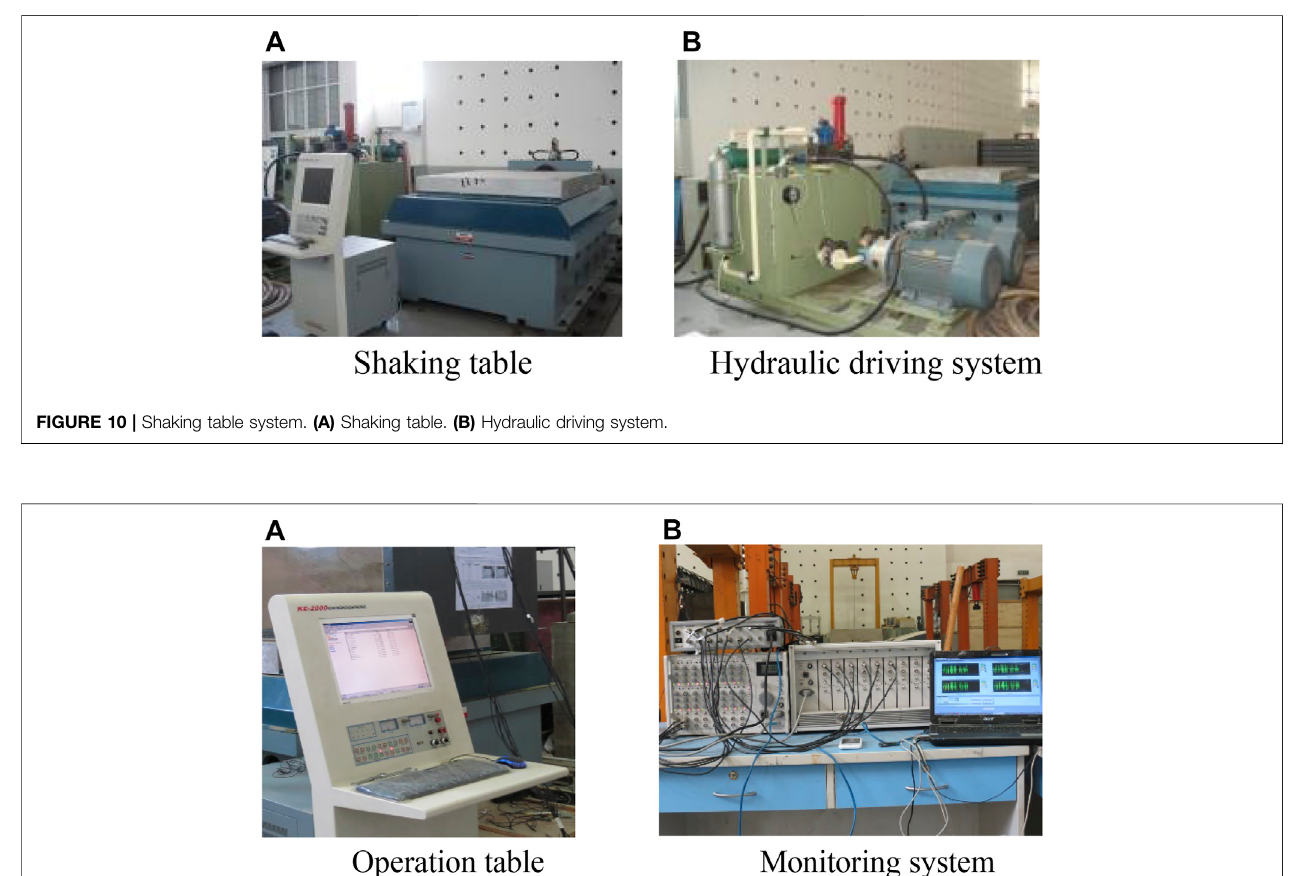
Frontiers in Earth Science |